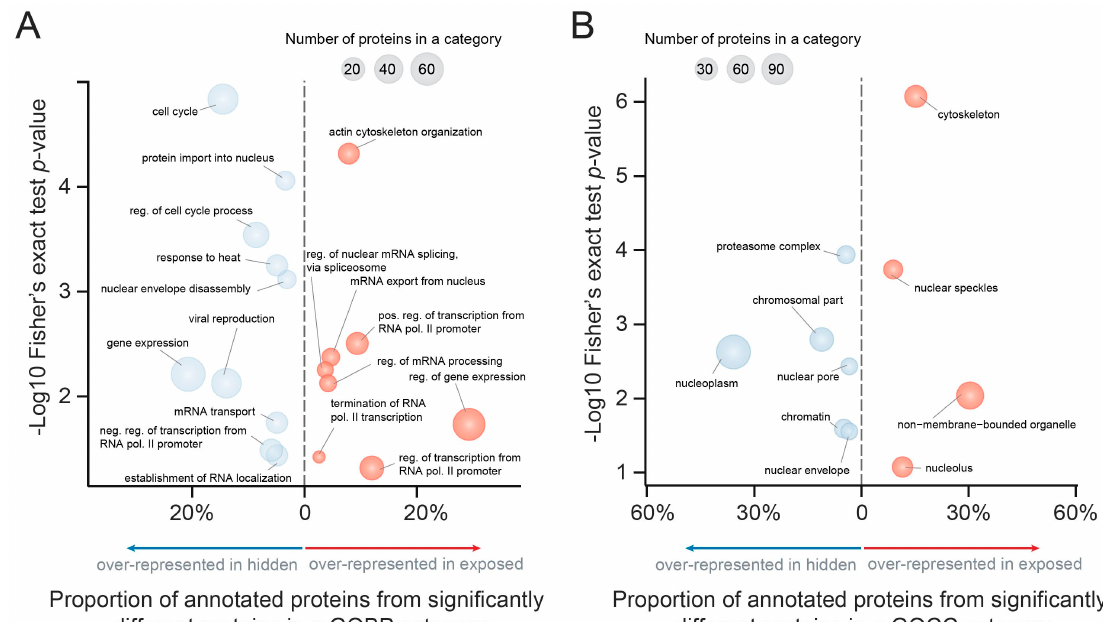
Figure 3. Gene ontology analysis of PIP2-effectors based on ( A ) biological process (GOBP) and ( B ) cellular compartment (GOCC). Bubble charts represent ‘exposed’ and ‘hidden’ proteins using all quantified proteins as a background reference set. X -axis shows the proportion of proteins from a gene ontology (GO) category from all proteins in the ‘exposed’ (red) or ‘hidden’ (blue) group. Y -axis shows the -log10 p -value estimated using Fisher’s exact test. The size of the bubble corresponds to number of proteins.